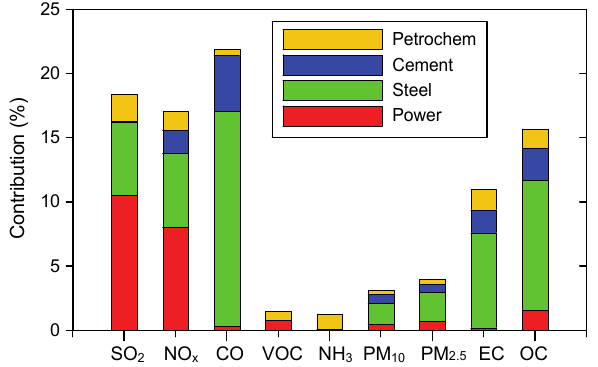
Fig. 5. Percent contributions of the point sources to the total emis- sions in the larger Huabei region for the year 2003. Different colours refer to power plants, steel plants, cement plants, and petro- chemical plants,